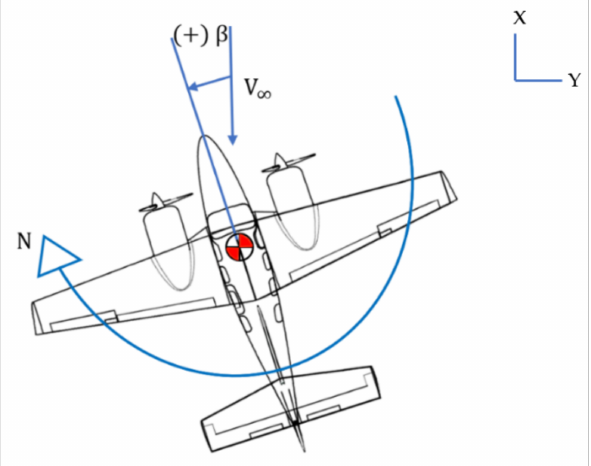
Figure 3. Aircraft in sideslip, β , with an offsetting yawing moment,